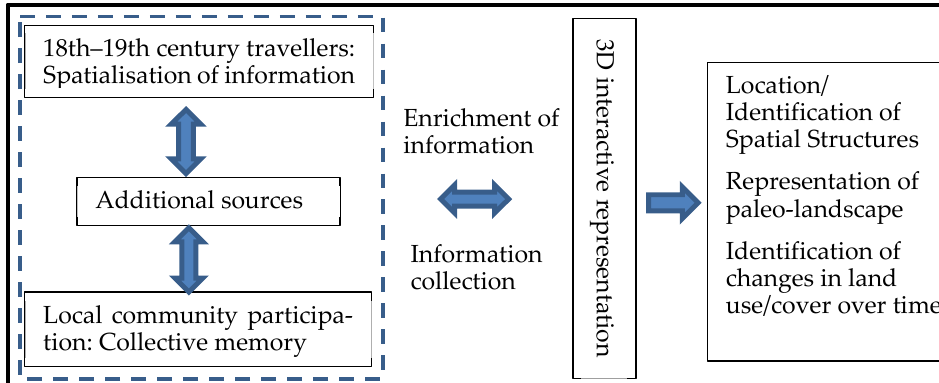
Figure 2. Flowchart of the proposed methodology.